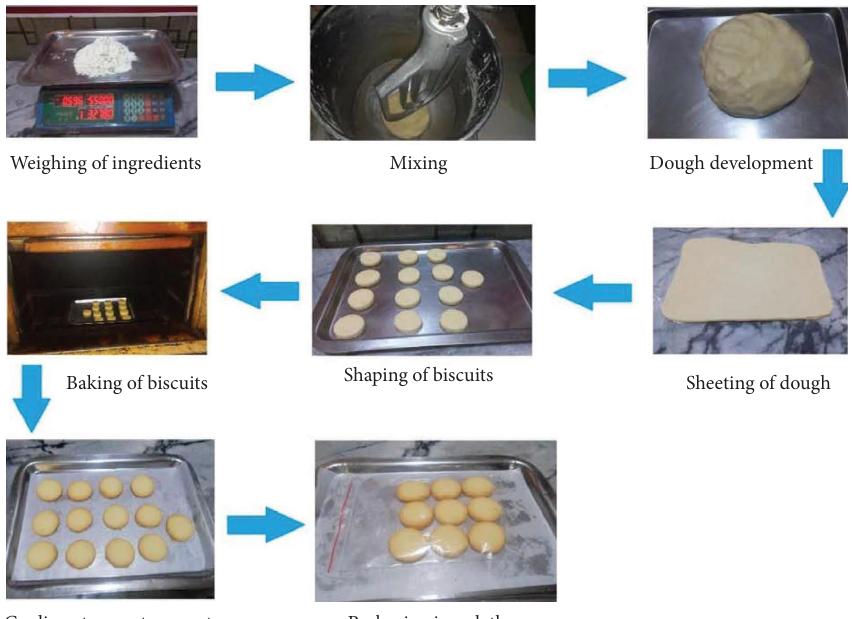
Figure 2: Flow diagram of preparation of biscuits.